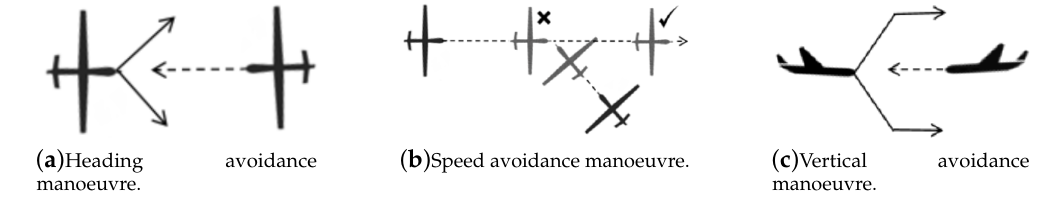
Figure 6. Different types of avoidance